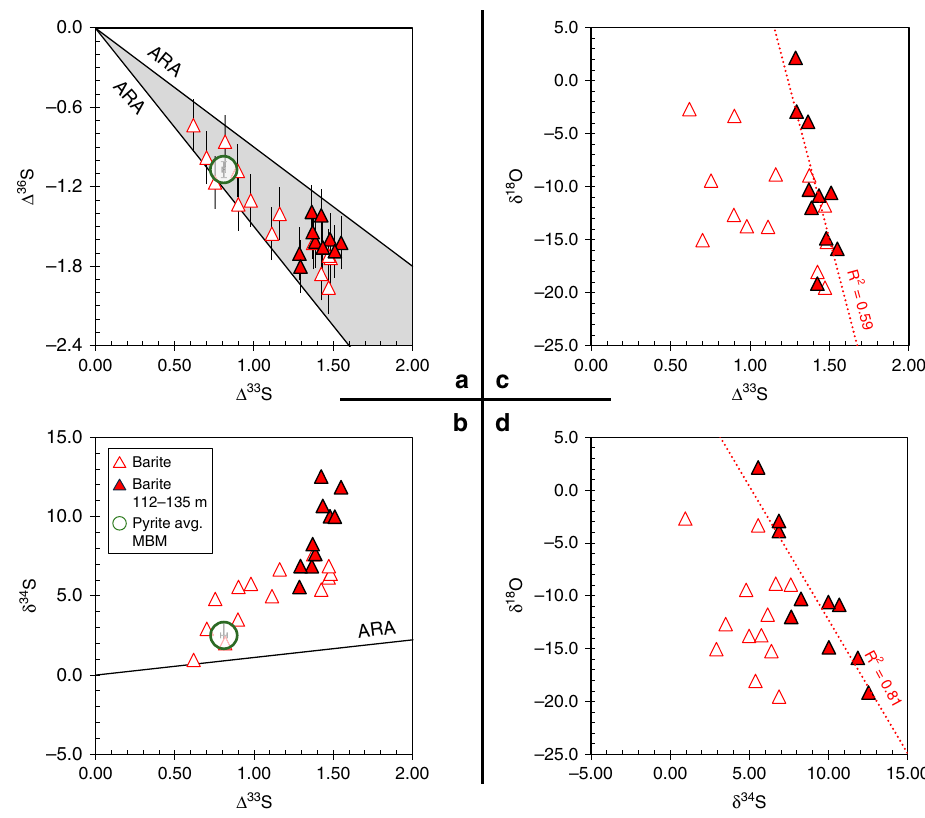
Fig. 3 sulfur and oxygen isotope systematics of barite data are shown from the Kazput Formation carbonate. The two left-hand plots, a , b show only sulfur data, while c , d show both oxygen and sulfur data. Analytical uncertainties are the same as in Fig. 2. ARA: Archaean Reference Array; 68 pyrite avg. MBM: average isotope composition of pyrite from the Meteorite Bore Member diamictite 16 . The ARA describes quadruple sulfur isotope correlations during the Archaean attributed to mass independent processes, where Δ 33 S = 0.9 × δ 34 S , and Δ 36 S = − 0.9 or − 1.5 × Δ 33 S 68 . See Methods for isotope notation de fi nitions and the Source Data fi le for